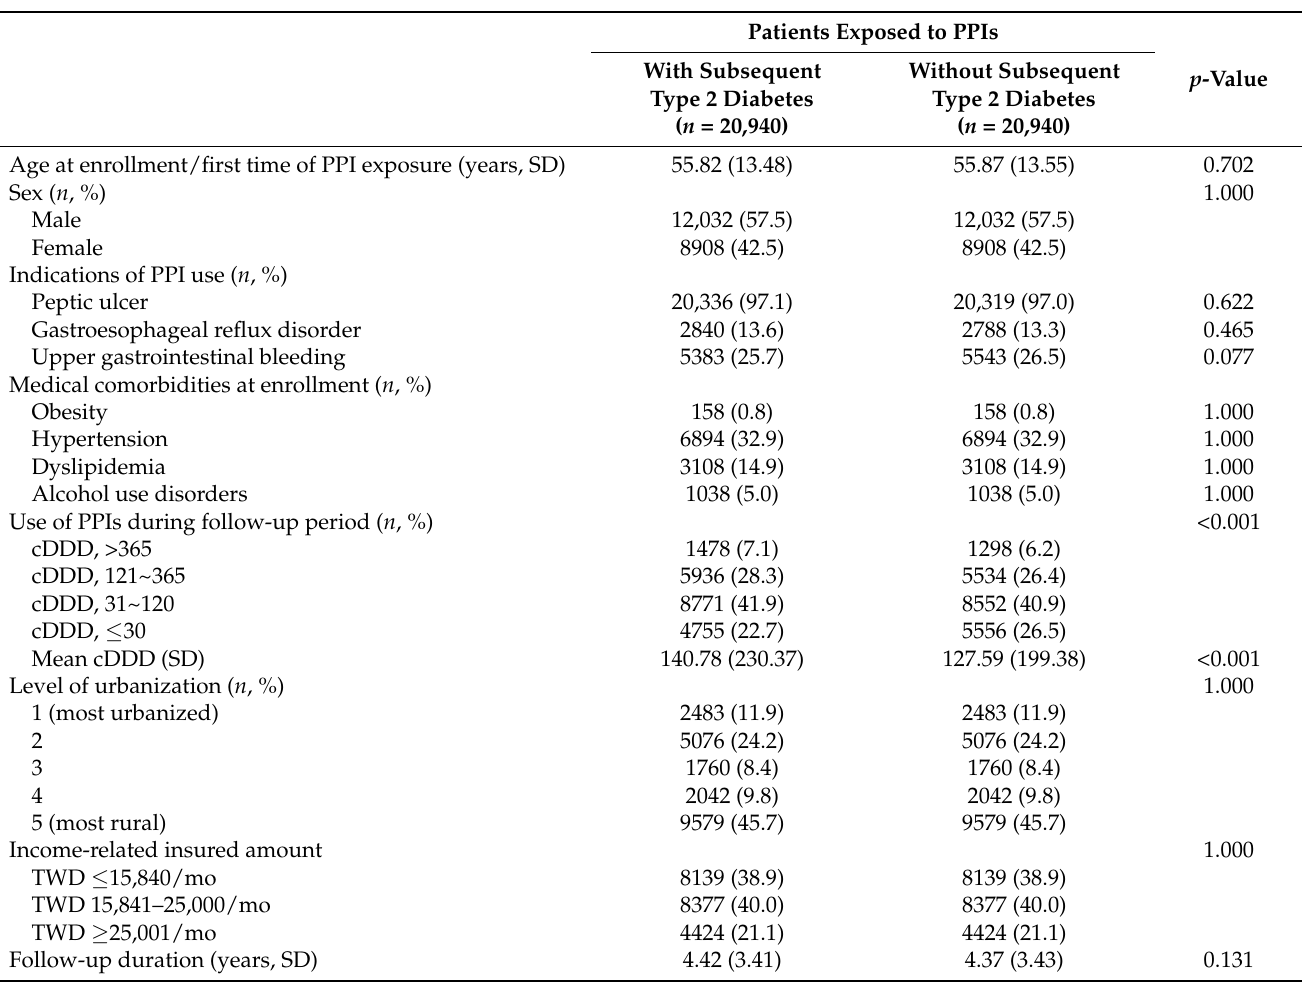
Table 1. Demographic characteristics of patients who were exposed to PPIs with or without subse- quent type 2